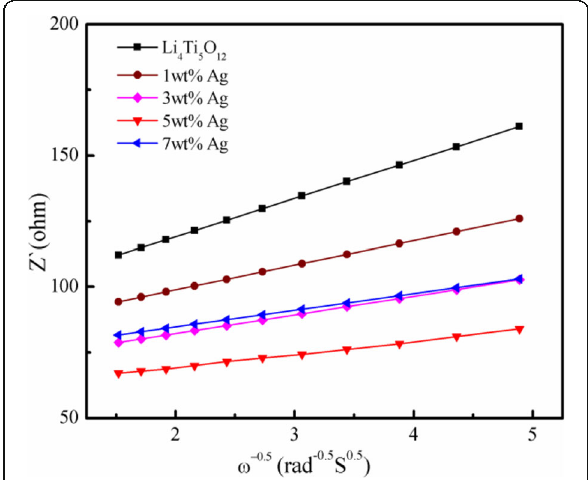
Fig. 9 Graph of Z re plotted against ω − 0.5 at the low frequency region for the Li 4 Ti 5 O 12 and Li 4 Ti 5 O 12 coated with different Ag contents